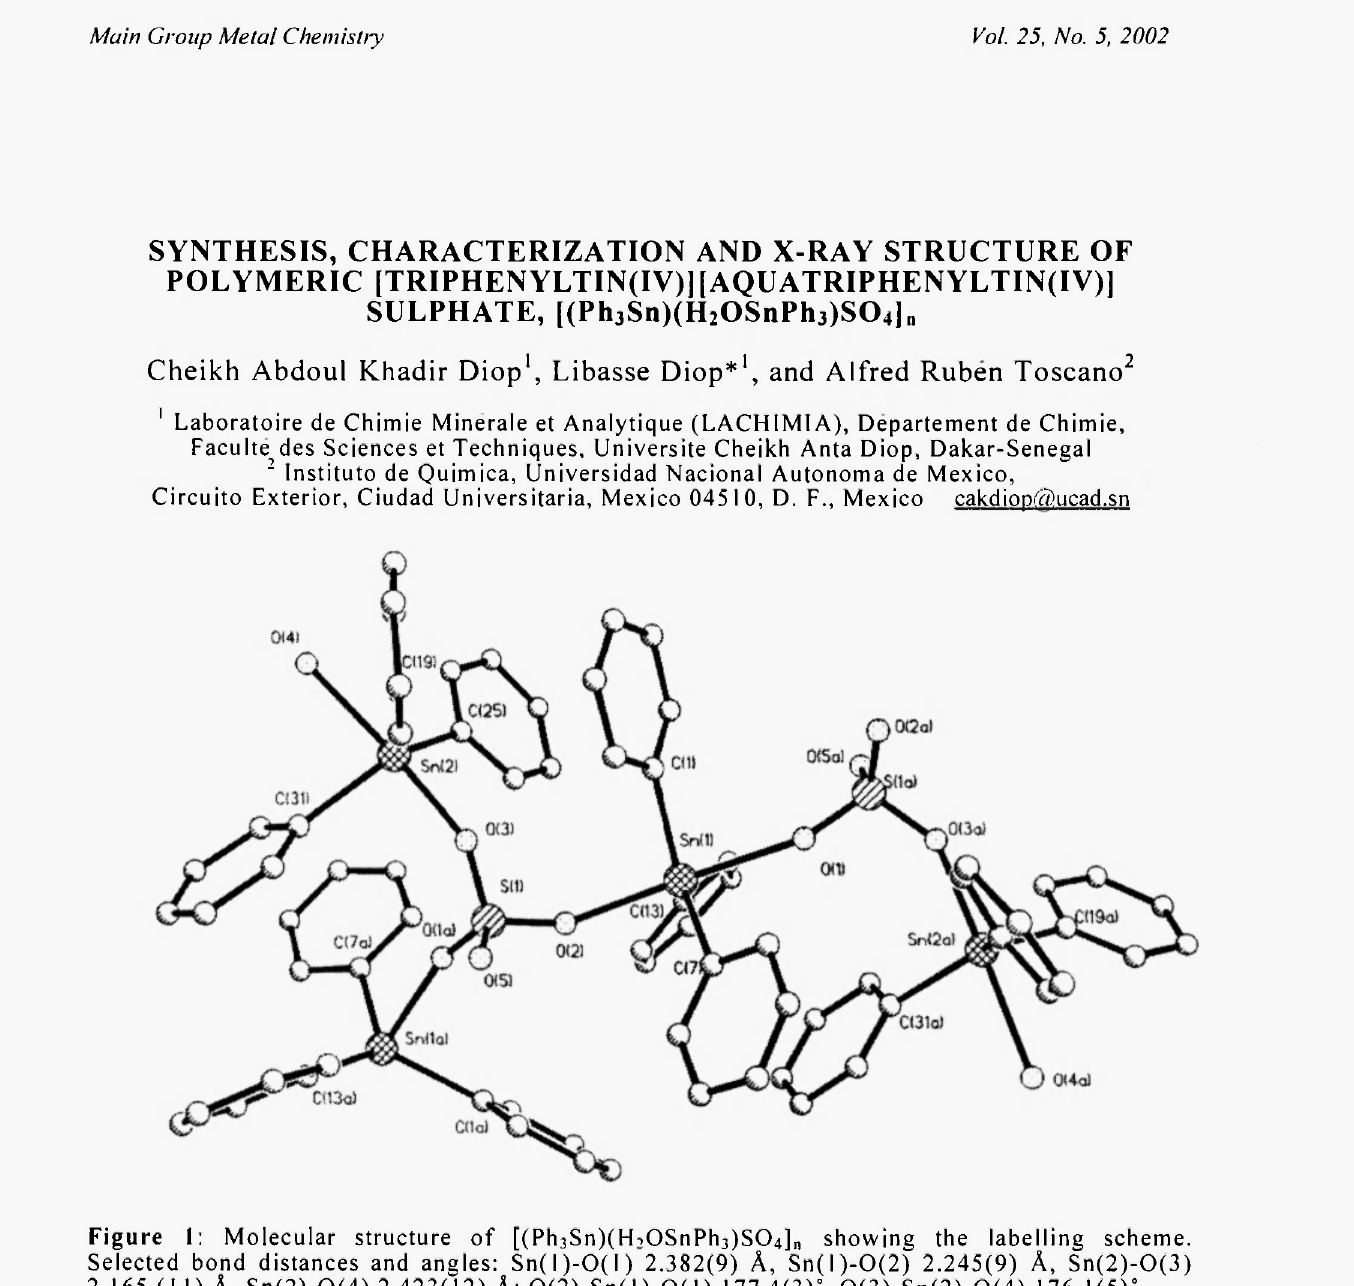
Figure 1: Molecular structure of [(Ph3Sn)(H->0SnPh 3 )S04]„ showing the labelling scheme. Selected bond distances and angles: S n ( l ) - 0 ( l) 2.382(9) Ä, S n ( l ) - 0 ( 2) 2.245(9) A, Sn(2)-0(3) 2.165 (I 1) A, Sn(2)-0(4) 2.423(12) A; 0(2)-Sn( 1 )-0( 1) 177.4(3)°, 0 ( 3 ) - S n ( 2 ) - 0 ( 4)